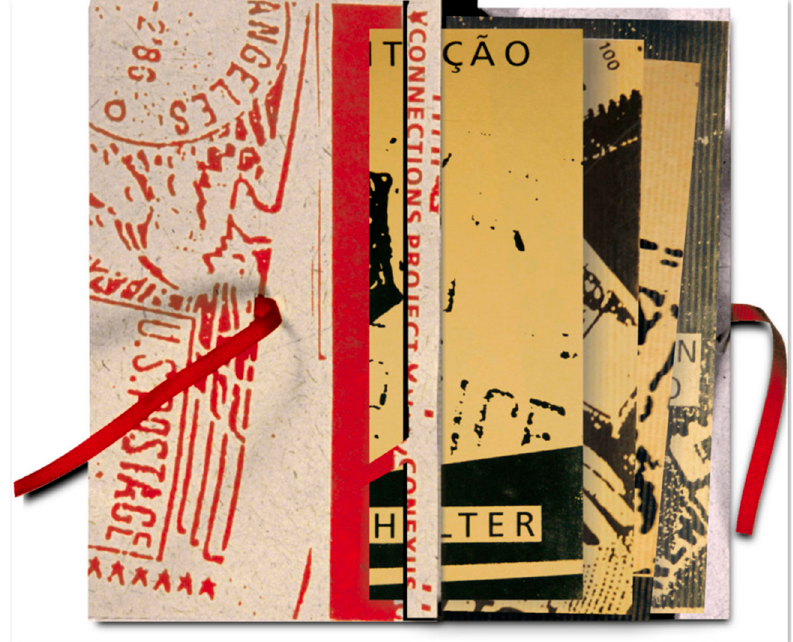
Figure 4. Josely Carvalho and Sabra Moore, Connections Project/Conexus|Projeto Conexões/Conexus , 1986, photocopies on Howard Bond Permalife Paper and screenprint on Indian handmade paper, 8.6 × 5.5 × 0.8 inches. Courtesy of the artist.